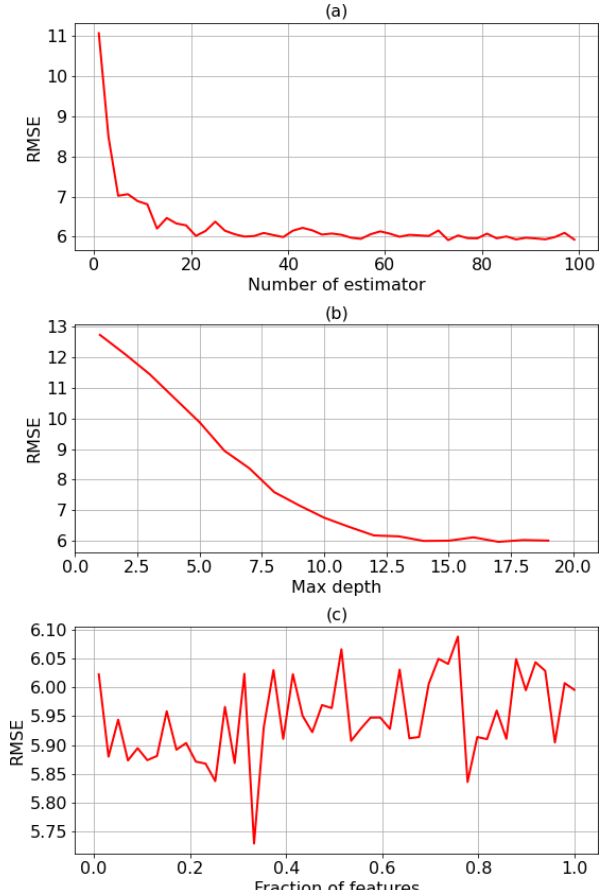
Figure A4. The parameter tuning process of the RF model (using RMSE as an